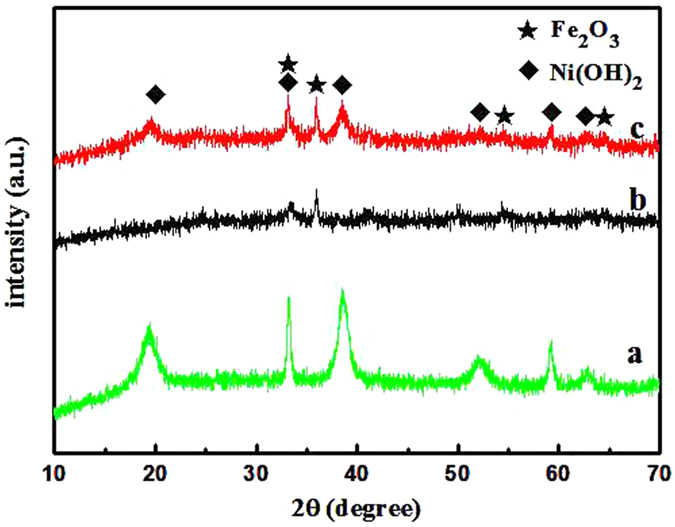
XRD patterns of (a) Ni(OH)2 nanosheets; (b) α-Fe2O3 nanosheets and (c) α-Fe2O3@Ni(OH)2 nanosheet hybrids.